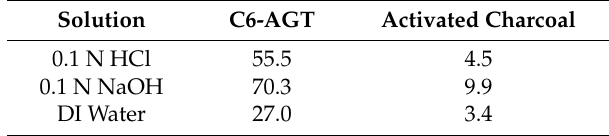
Table 5. Percentages of 2-CP desorbed using aq. acid, aq. base, and neutral water.